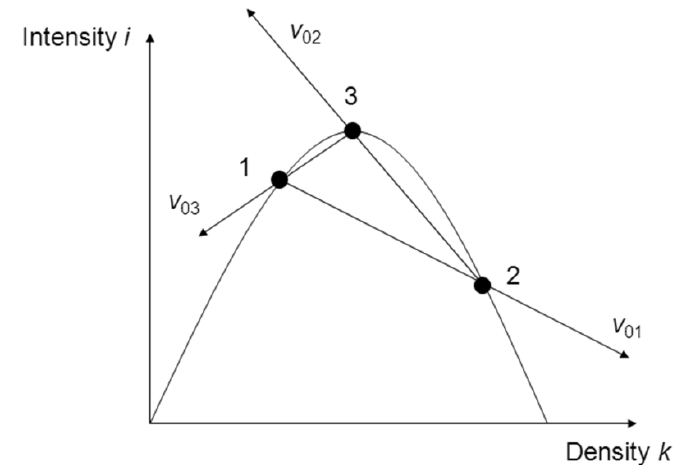
Figure 3. Operation traffic states when a perturbation